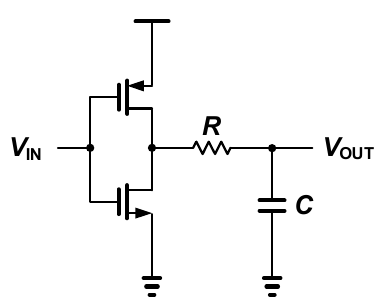
Figure 2. Simple delay cell using a passive resistor and capacitor.